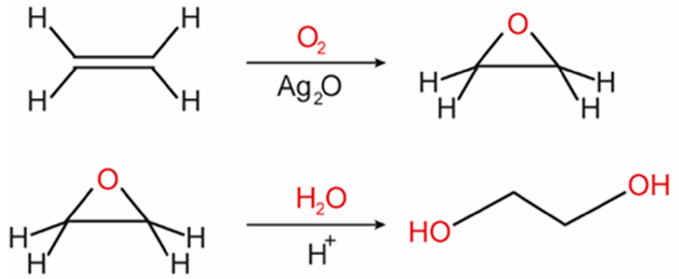
Figure 12. Industrial synthesis of ethylene glycol from ethylene gas.